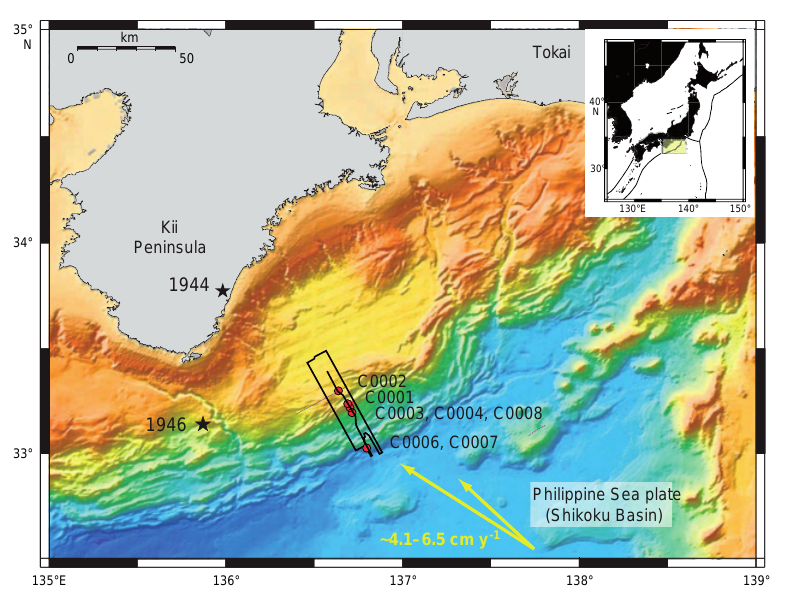
Figure 1. Location of sites drilled during the three expeditions of NanTroSEIZE Stage 1 (red circles) in the Nankai Trough off Kumano, Japan. Black box = location of the 2006 3-D seismic survey, black line = arbitrary line extracted from 3-D seismic volume (Fig. 3), yellow arrows = computed far-field convergence vectors between Philippine Sea plate and Japan (Seno et al., 1993; Heki, 2007). Stars = epicentral location of great earthquakes. Inset shows location of Nankai